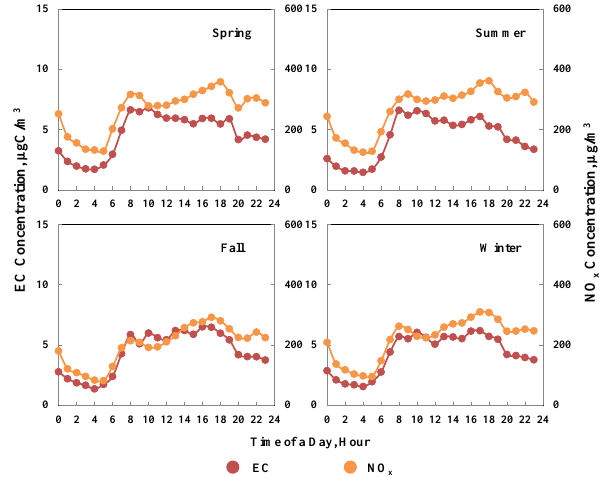
Figure 4 . Diurnal variations of EC (µgC/m 3 ) and NO x (µg/m 3 ) at MK AQMS during different Figure 4. Diurnal variations of EC (µgCm − 3 ) and NO x (µgm − 3 ) seasons. at MK AQMS during different seasons.